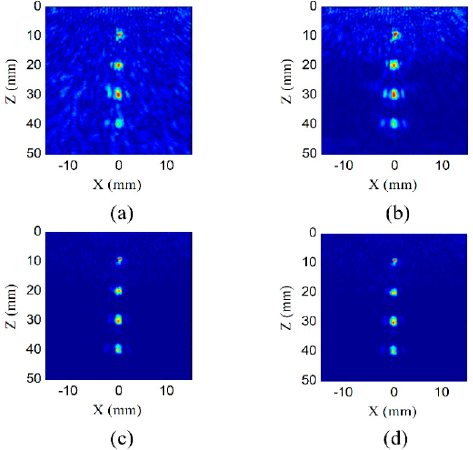
Figure 9. TFM images for ( a ) α = 20 × 10 5 s − 1 , ( b ) α = 20 × 10 6 s − 1 ; SCF images for ( c ) α = 20 × 10 5 s − 1 , ( d ) α = 20 × 10 6 s − 1 .